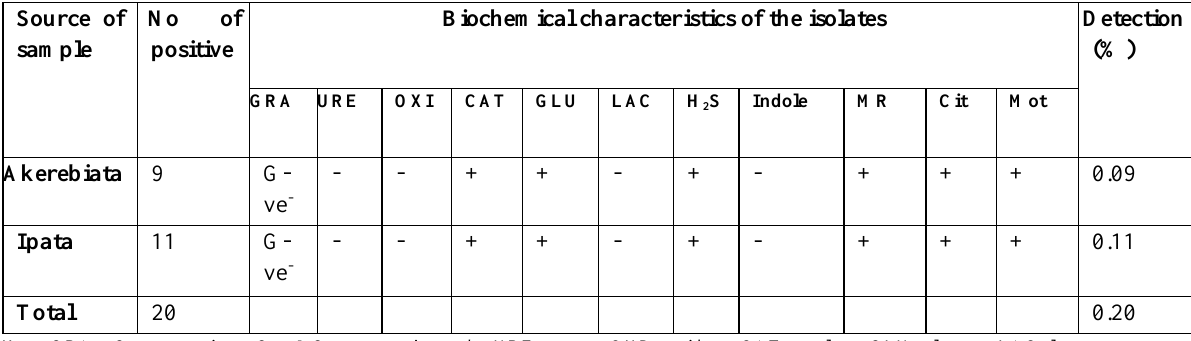
Table 3. Biochemical characteristics of Campylobacter isolates from ruminants slaughtered at major abattoirs in Ilorin, Kwara State, Nigeria.